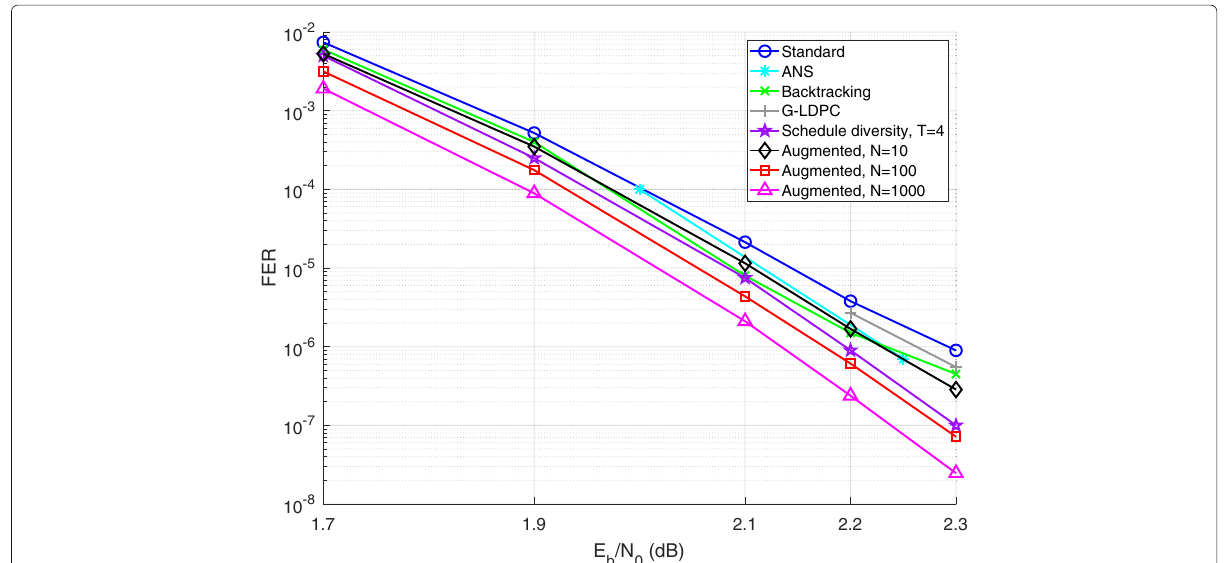
Fig. 9 Margulis FER plot. FER performance of augmented decoders for the n = 2640 and R = 1 / 2 Margulis code. Also shown are the performances of ANS, backtracking, G-LDPC, and schedule diversity